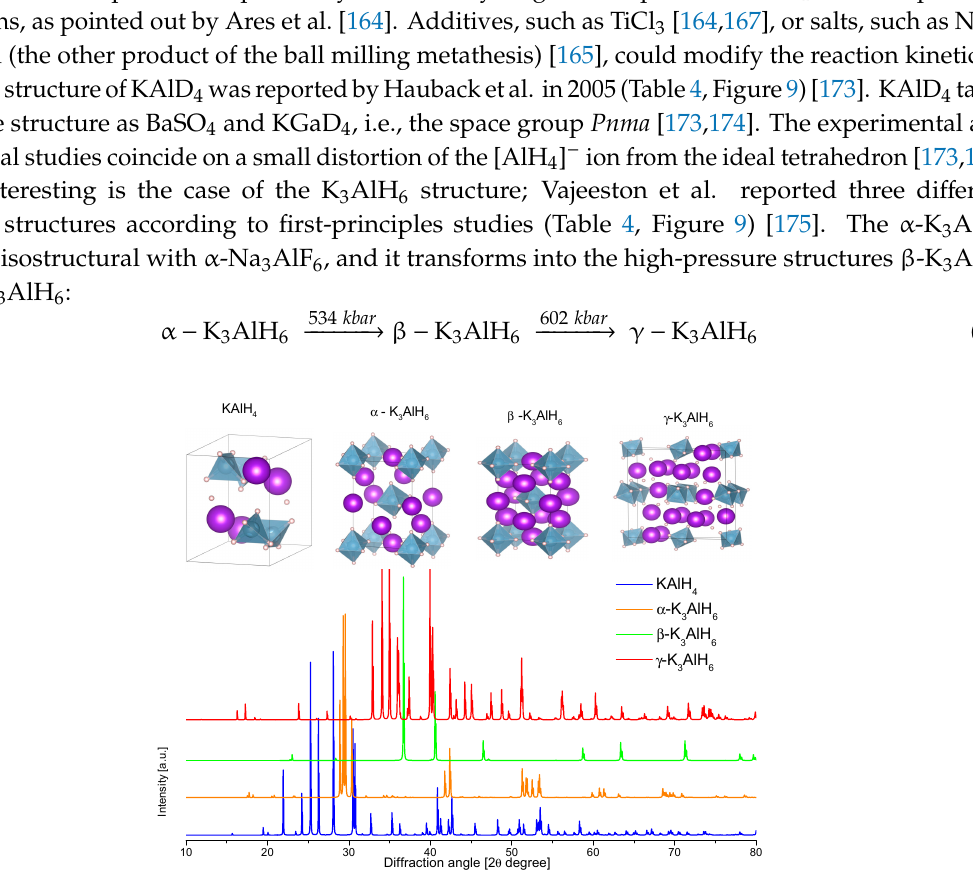
Figure 9. Crystal structure of potassium alanates and their calculated diffraction patterns ( λ = Cu k α 1 ). The experimental dehydrogenation enthalpies for reactions (34) and (35) are 70 ± 2 and 81 ± 2 kJ/mol H 2 , respectively [167]. A phase diagram was generated with these values (Figure 10). In this diagram, the feasibility of hydrogenation at low pressure is evident and it justifies the rehydrogenation without the need for a catalyst or additives.